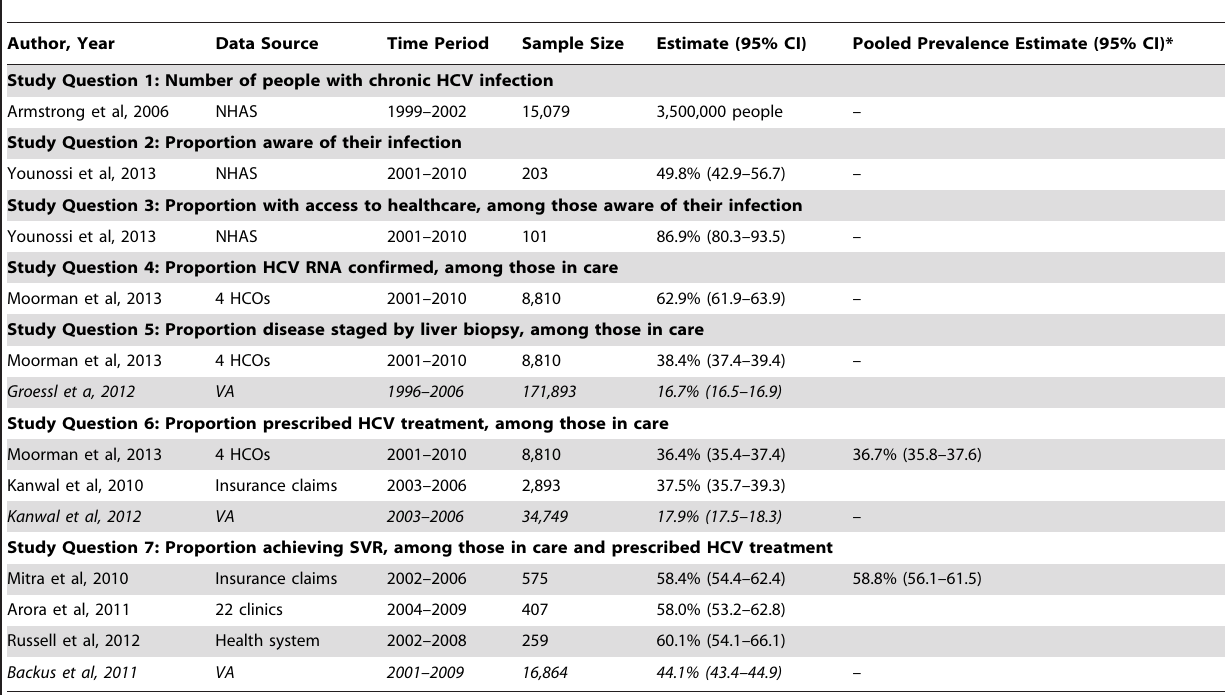
Table 1. Evaluation of chronic hepatitis C virus treatment cascade studies eligible for final